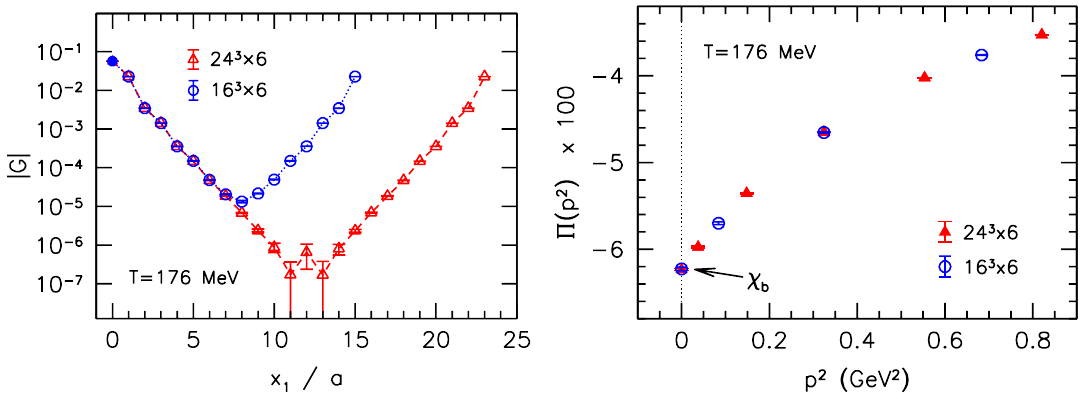
Figure 1 . Left panel: comparison of the absolute value of the current-current correlator for two di(cid:11)erent volumes, 24 3 (cid:2) 6 (red) and 16 3 (cid:2) 6 (blue). Filled (open) points indicate positive (negative) values. Right panel: the vacuum polarization function at spatial momenta for T (cid:25) 176 MeV using two di(cid:11)erent volumes. The bare magnetic susceptibility can be read o(cid:11) from the intersect